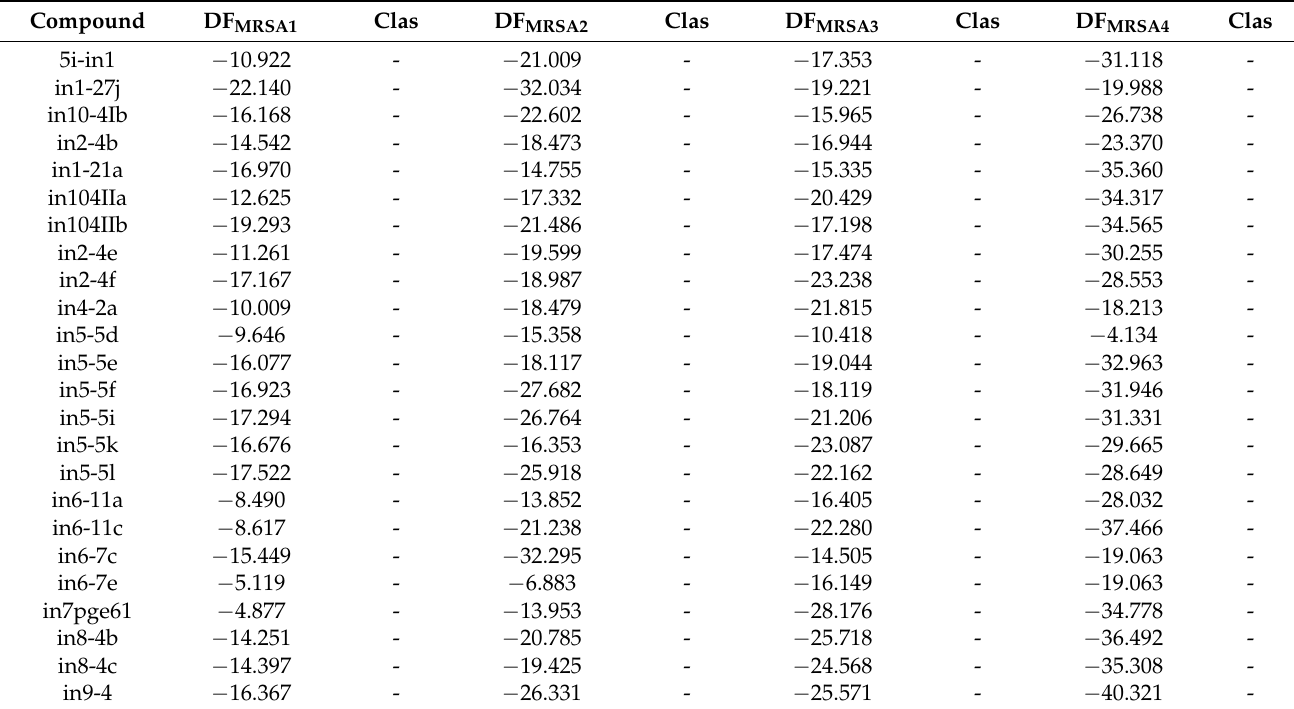
Table 6. Results obtained after combining LDA and PDD for the DFs. Training group: